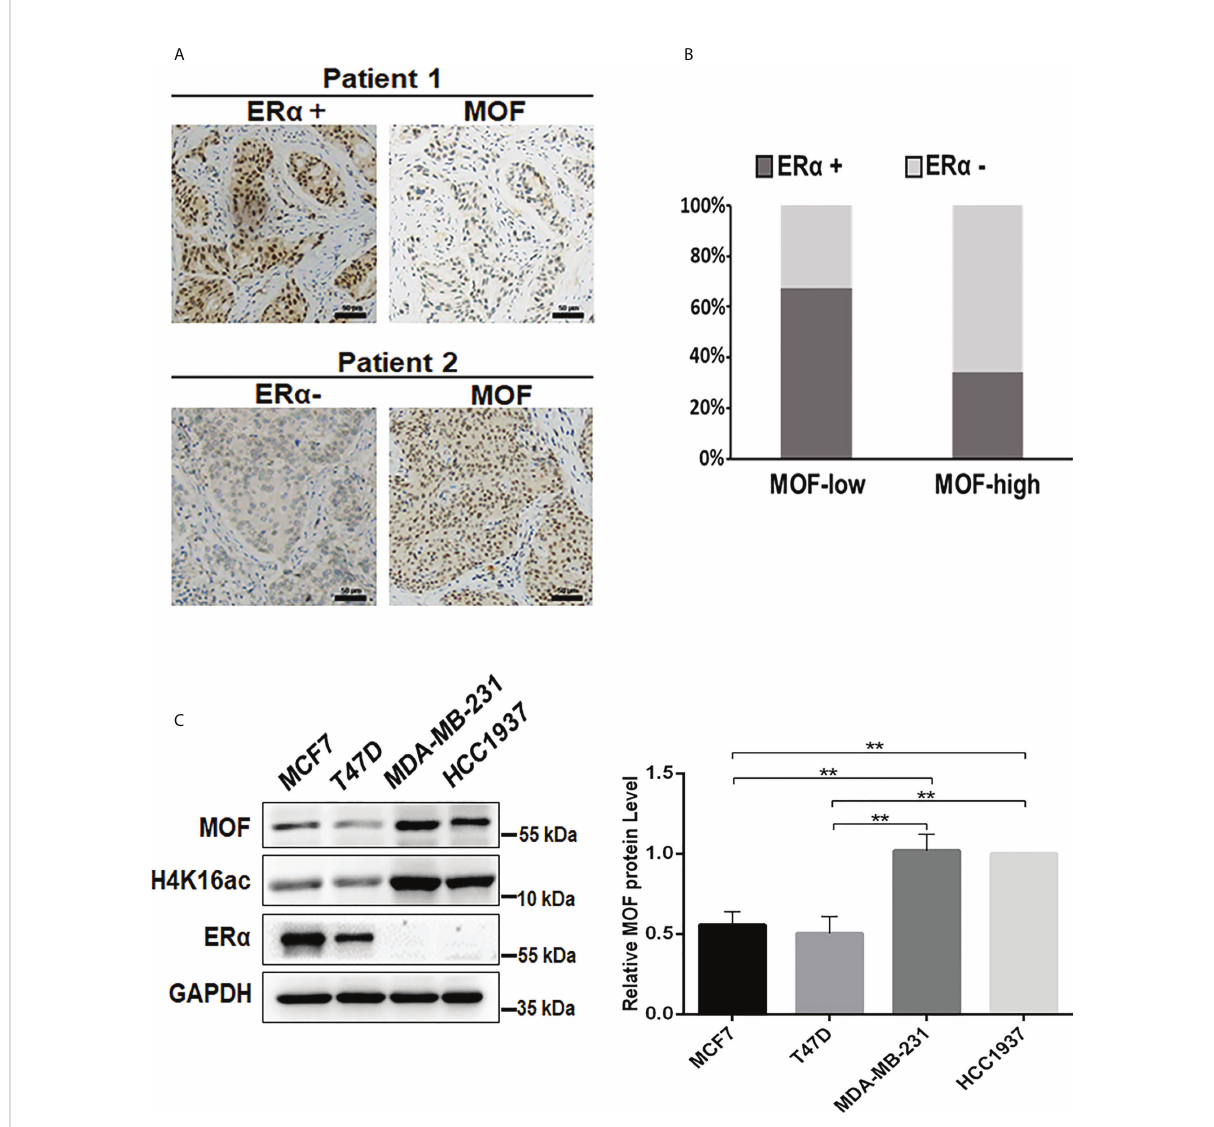
FIGURE 1 Analysis of the expression correlation of MOF and ER a in BC tissues and cells. (A) The protein abundance of MOF and ER a in BC tissue chip was determined by IHC staining, and the representative images were shown as high/positive and low/negative levels of MOF and ER a . Bar = 50 m m. (B) The staining results were quanti fi ed to demonstrate the correlation between MOF and ER a expression in BC tissues (n = 78). The staining was de fi ned as high/positive (strong or moderate) and low/negative (weak or none) levels of expression. (C) The protein levels of MOF and ER a was analyzed by Western blot in BC cells, including ER a + BC cells (MCF7 and T47D) and ER a − BC cells (MDA-MB-231). **P < 0.01 vs. control